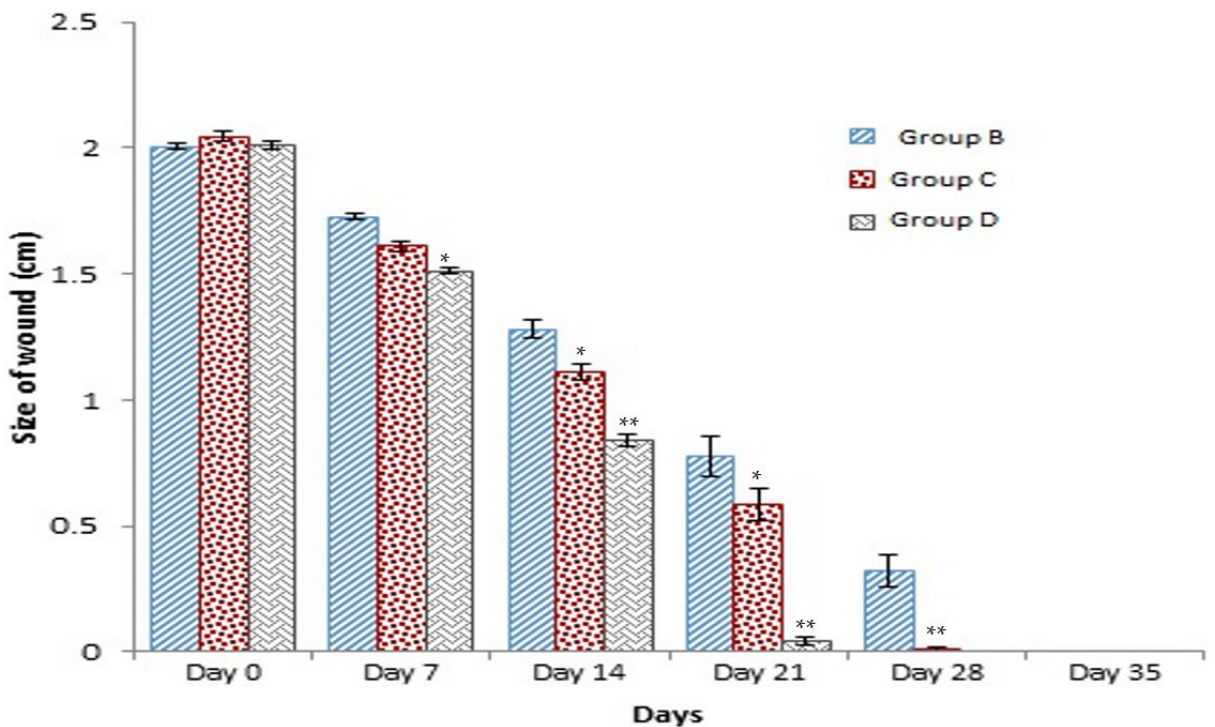
Table 7. Healing of wound at different time